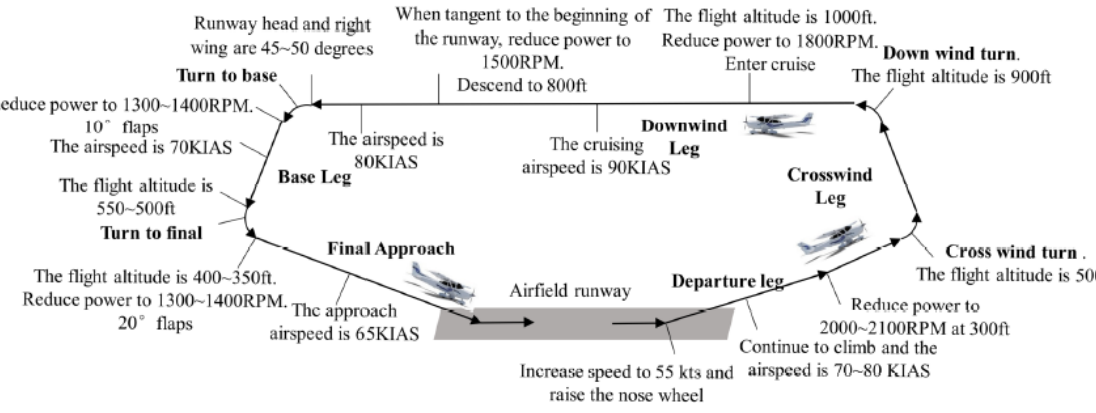
10 of 24 ( c ) Figure 5. Flight simulation experiment equipment. ( a ) Cessna 172 flight simulator. ( b ) Simulator panels of Cessna 172 flight simulator. ( c ) The wireless wearable ECG data acquisition and recording device. Table 5. Parameters of wireless wearable ECG sensor. Name